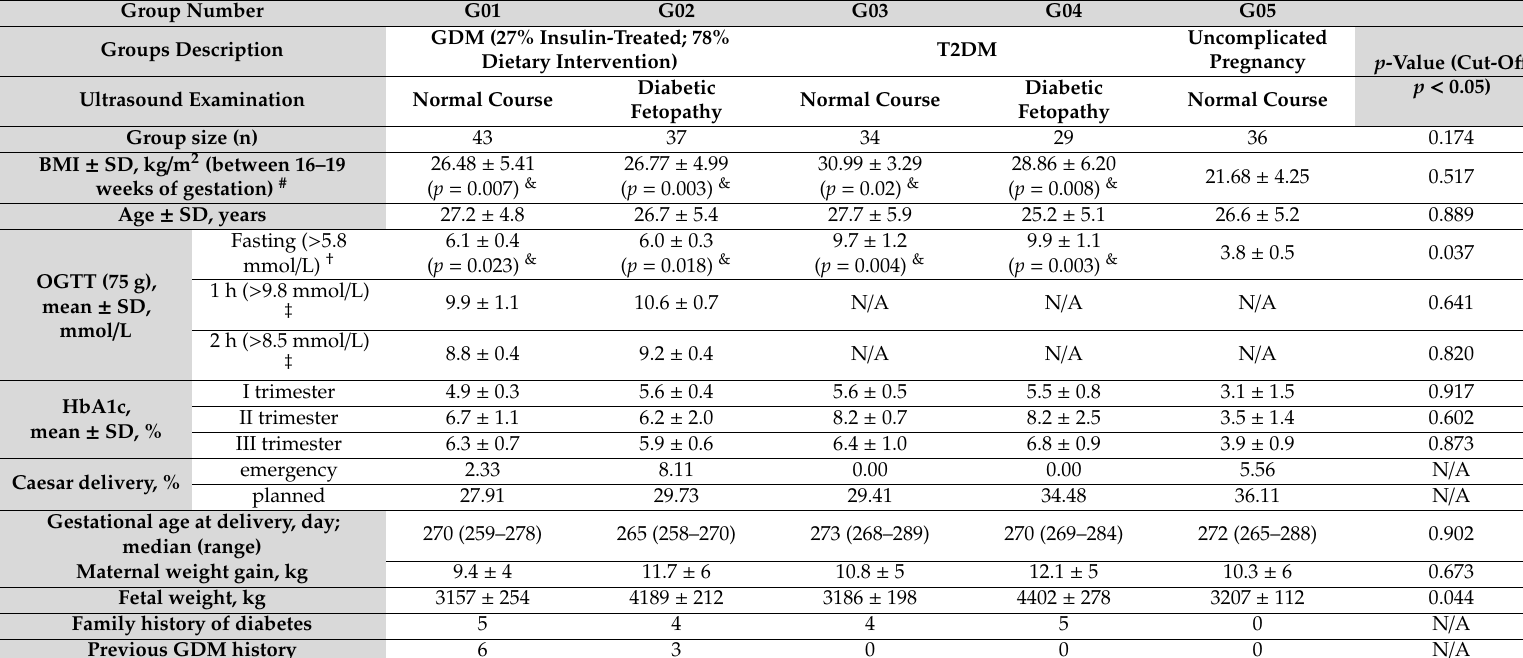
Table 1. Summary of the main anthropometric data and measurements of glucose level for patients in study groups. The groups were aligned at BMI (body mass index) value which was measured between 16–19 weeks of gestational age. The GDM was established by 75-g OGTT (oral glucose tolerance test) conducted according the recommendations of IADPSG (revision 2010) [20] adopted by Russian Association of Obstetrician and Gynecologist (revision 2012) [21]. Diabetic fetopathy was diagnosed by ultrasound examination between 22–35 gestation weeks according to the inclusion